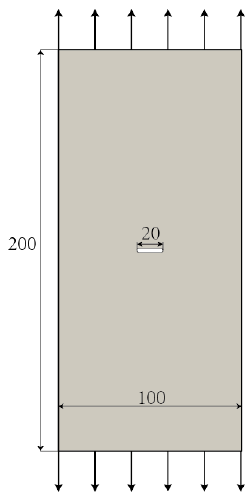
Figure 3. the central cracked plate(unit:mm). Figure 3. The central cracked plate